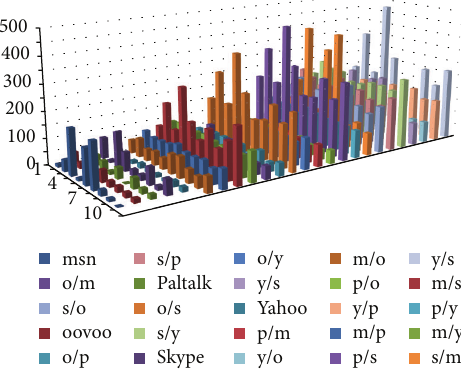
Figure 17: Experimental results of AC-matching and histogram method.